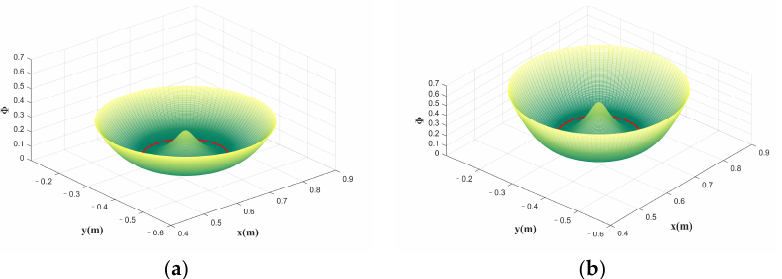
Figure 8. The effect of the potential field stiffness coefficient 𝐾 on the potential field. ( a ) 𝐾 = 6 ( b ) 𝐾 = 12 . Higher potential energy provides greater assistance force.